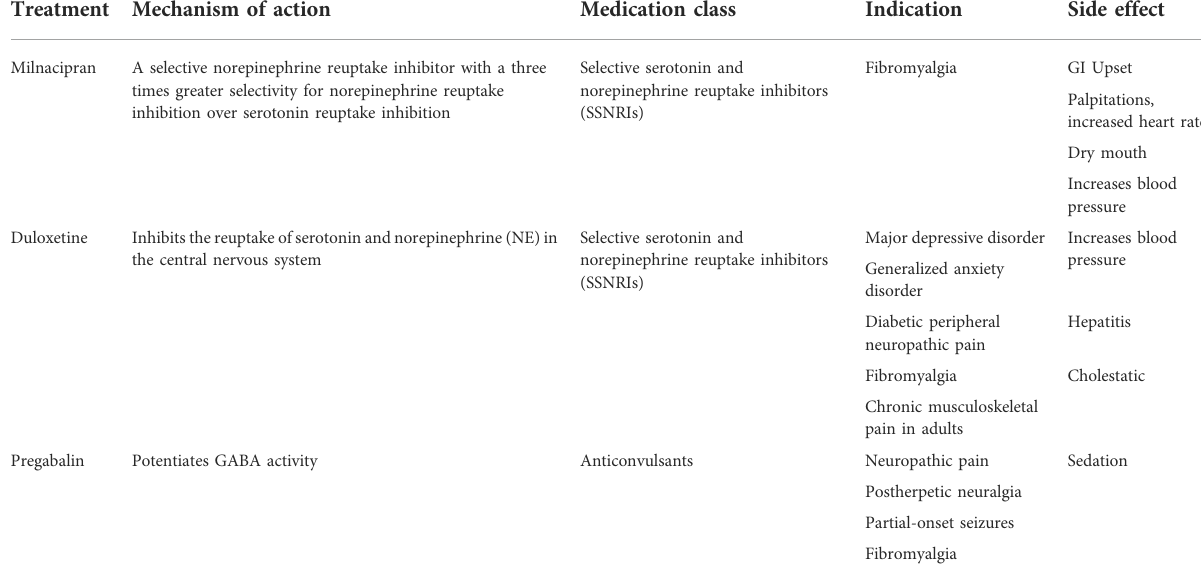
TABLE 2 FDA-approved drugs for the treatment of fi bromyalgia. Treatment Mechanism of